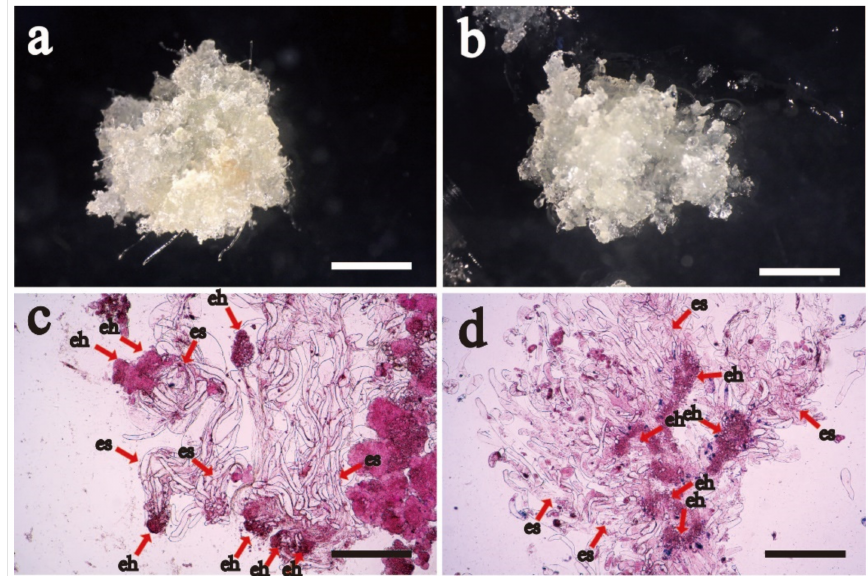
Figure 1. Macrostructural and cytological observation of embryogenic callus in F and S Korean pine cell lines. Note: ( a ) F cell line macrostructure, bar = 1 cm; ( b ) S cell line macrostructure, bar = 1 cm; ( c ) F cell line cytological structure, bar = 150 µ m; and ( d ) S cell line cytological structure, bar = 150 µ m. The letters eh denote the embryo head (eh), and the letter s denotes the suspensor